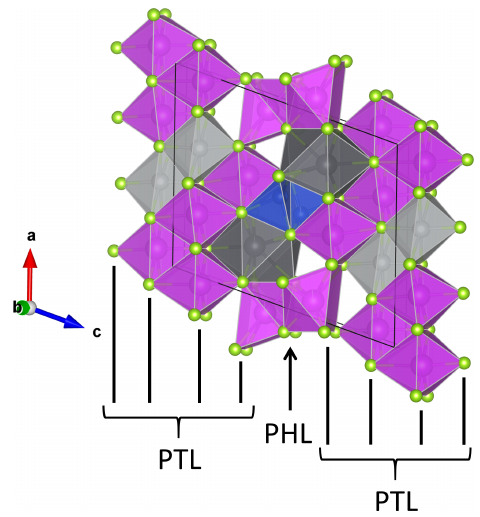
Figure 2. The crystal structure of luxembourgite viewed approxi- mately perpendicular to the b axis. Se atoms are yellow, Bi polyhe- dra are purple, Cu tetrahedra are blue, Ag polyhedra are light grey, and Pb polyhedra are dark grey. Vertical black lines indicate the directions of pseudotetragonal layers (PTLs) and pseudohexagonal layers (PHLs) constituted by Se atoms.